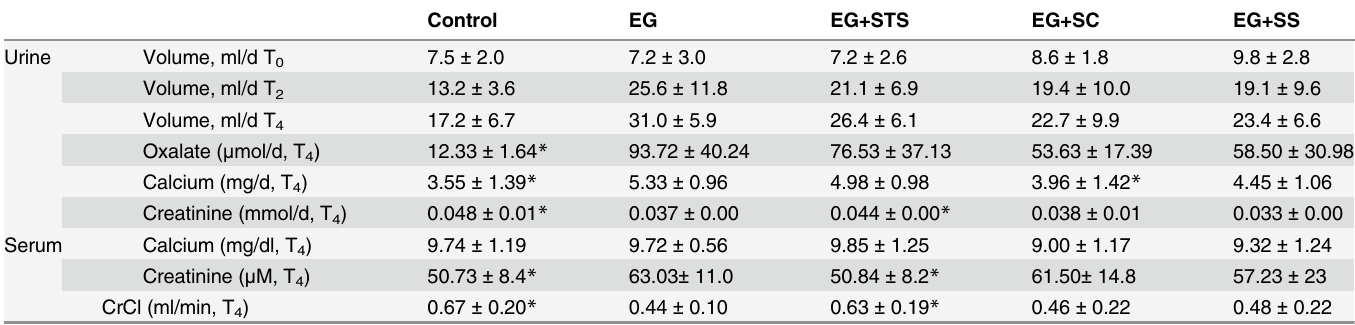
Table 1. Urine and serum biochemistry.